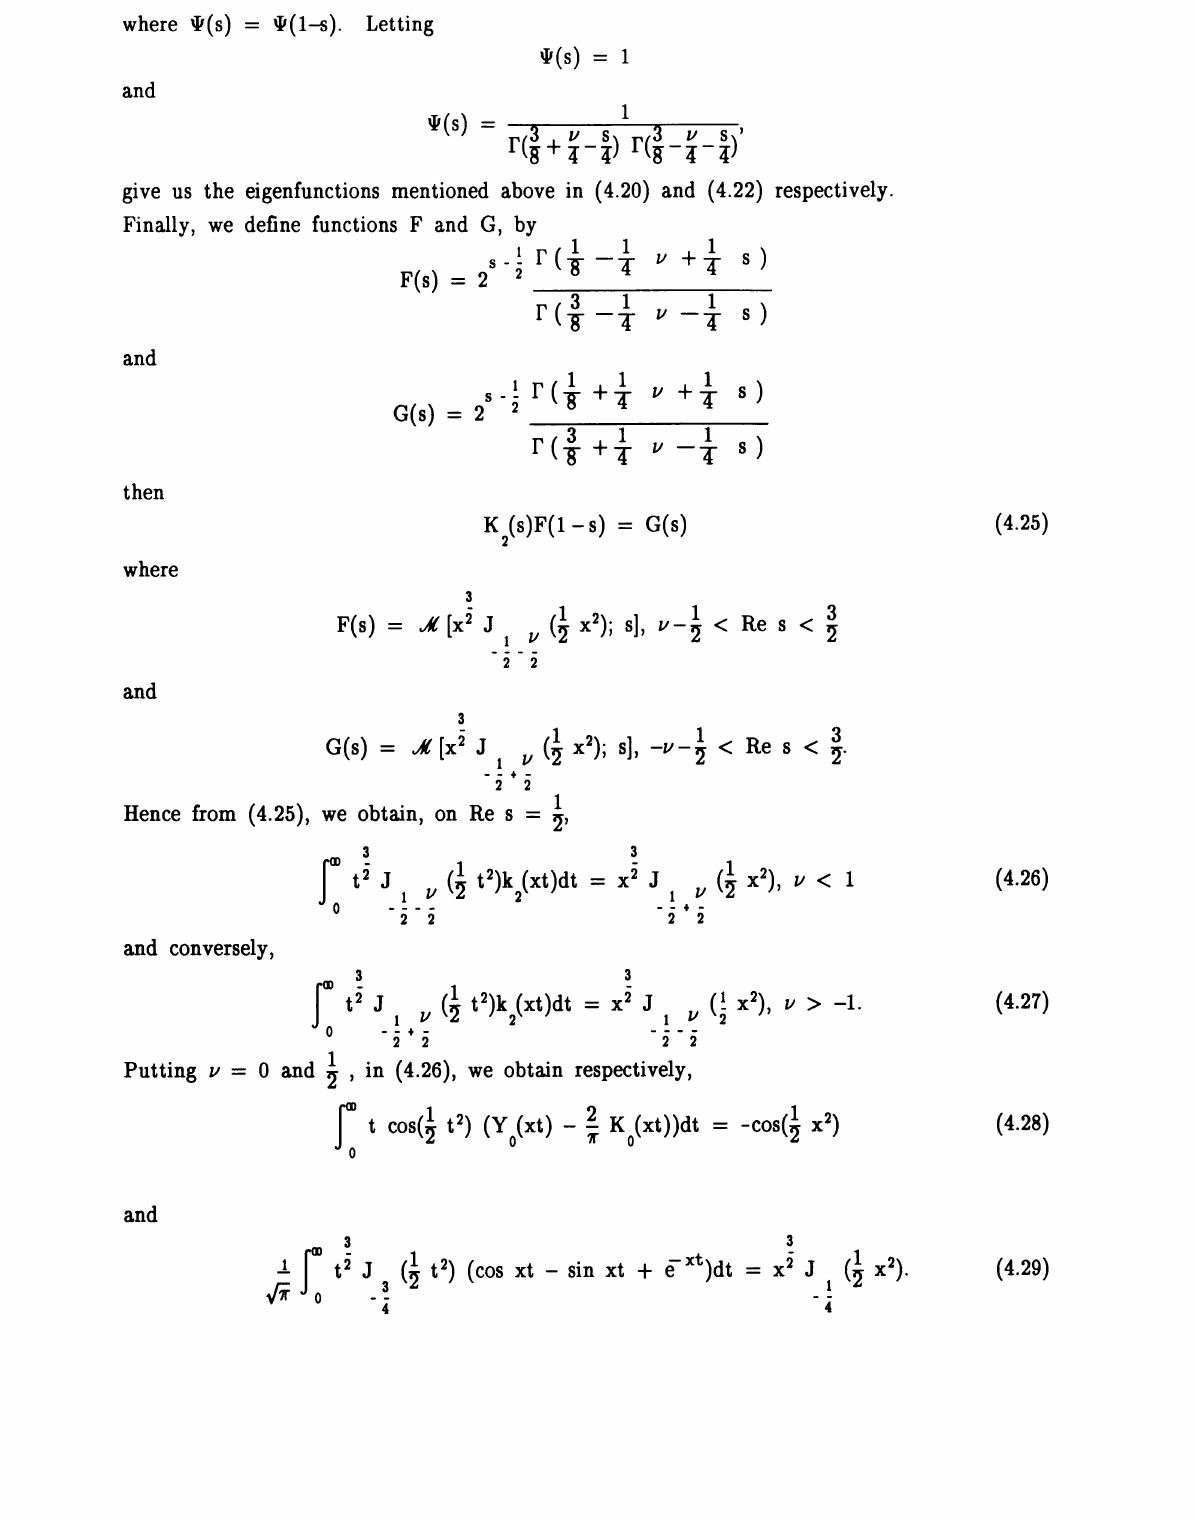
Mellin transform